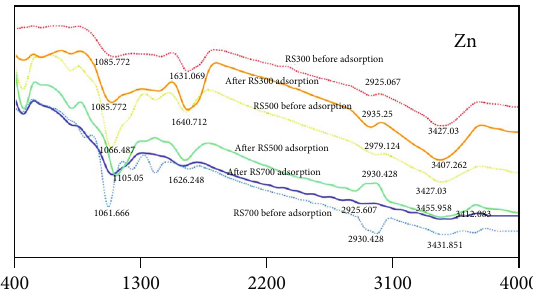
Figure 18: Competitive adsorption mechanism of Zn 2+ in acid solution of